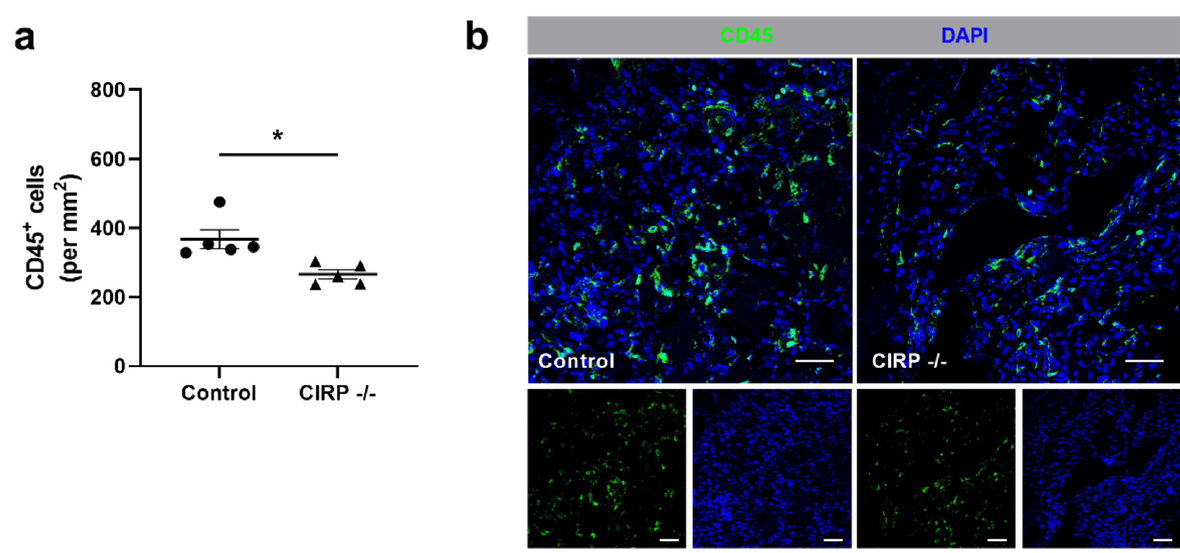
Figure 3. Cold-inducible RNA-binding protein (CIRP) knockout decreases leukocyte infiltration in ischemic tissue. ( a ) The scatter plot displays the relative amount of CD45+ (pan-leukocyte marker) cells (per mm 2 ) of ischemic gastrocnemius muscles of wildtype and CIRP -/- mice 7 days after femoral artery ligation (FAL). Data are means ± S.E.M., n = 5 per group. * p < 0.05 (CIRP -/- vs. control) by unpaired, two-sided student’s t-test. ( b ) Representative immunofluorescence stainings of ischemic gastrocnemius muscles of CIRP wildtype control (left) and CIRP -/- (right) mice 7 days after FAL. Smaller images display single channels, large images merged channels of leukocytes (anti-CD45, green) and nucleic acid (DAPI, blue) stains. Scale bars 50 µm.